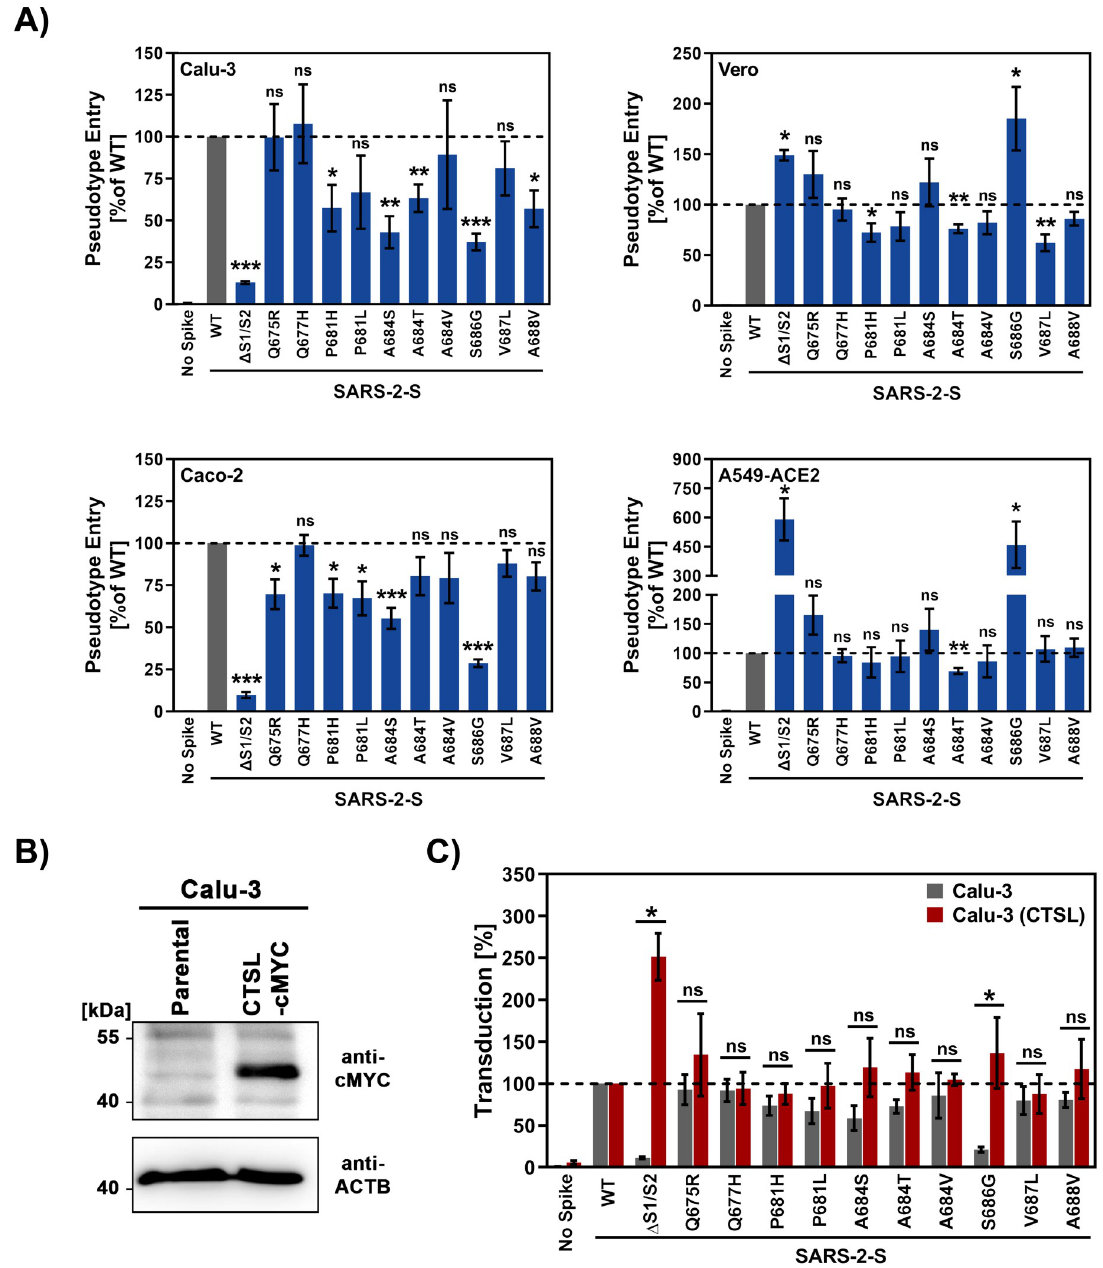
Fig 4. S686G modulates SARS-CoV-2 S-driven entry in a cell line-dependent manner. A) The indicated cell lines were inoculated with equal volumes of pseudotyped particles bearing the indicated S proteins or no S protein (negative control). Transduction efficiency was quantified by measuring virus encoded luciferase activity in cell lysates at 16–20 h post transduction. The average from six independent experiments is shown. Error bars represent SEM. B) Stable overexpression of cathepsin L (CTSL) in Calu-3 cells. Cell lysates of parental Calu-3 cells and Calu-3 cells stably expressing CTSL harbouring a C-terminal cMYC epitope tag (CTSL-cMYC) were subjected to immunoblot analysis using anti-cMYC antibody. Detection of beta-actin (ACTB) served as a loading control. Shown is a representative immunoblot from two independent experiments. C) The experiment was carried out as described for panel A but entry into Calu-3 WT and Calu-3 cells stably expressing CTSL was analysed. Statistical significance was analysed by two-tailed Student’s t-test with Welch’s correction (p > 0.05, not significant [ns], p � 0.05, � ; p � 0.01, �� ; p � 0.001, ��� ). WT = wildtype.